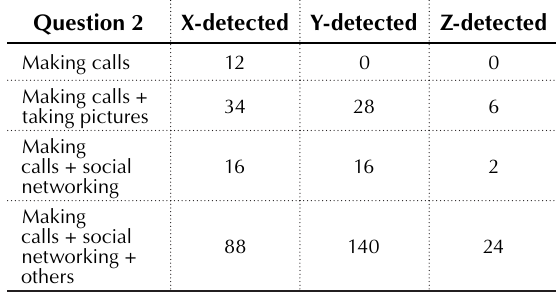
Table 1. The obtained data